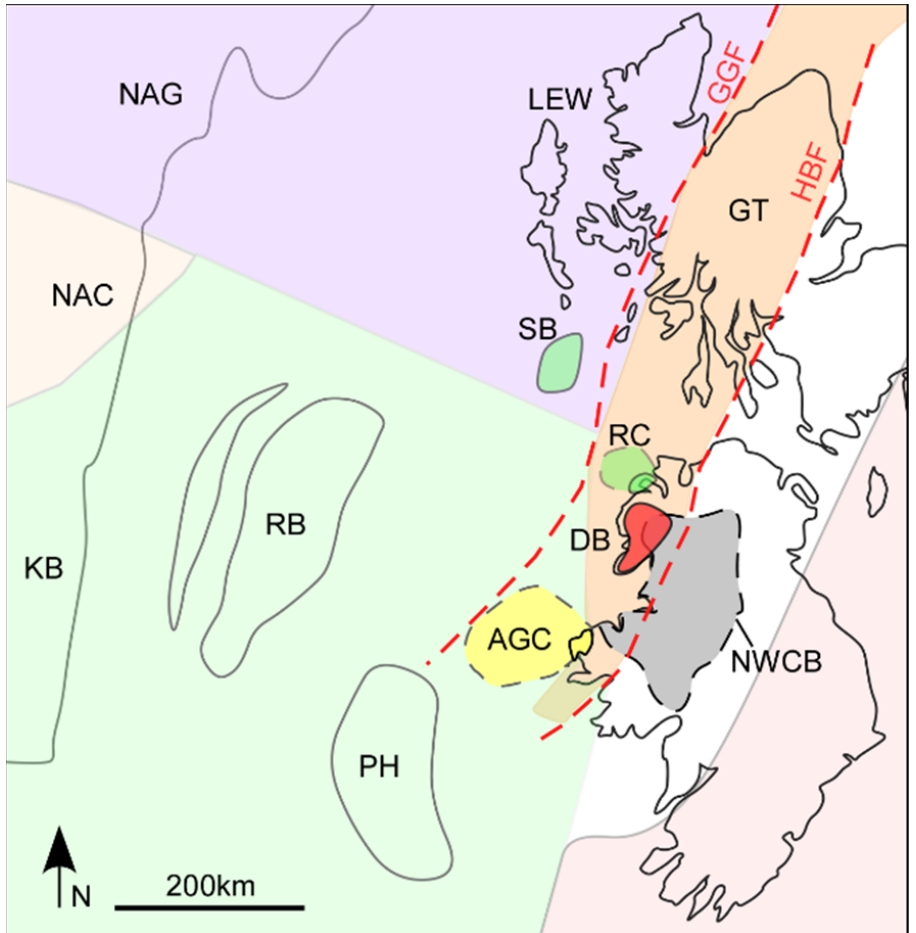
Figure 2. Potential northern source terranes after Anders et al. [48]. NAG: Nagssugtoqidian; NAC: North Atlantic Craton; KB: Ketilidian Belt; LEW: Lewisian; SB: Stanton Banks; RC: Rhinns Complex; RB: Rockall Bank; PH: Porcupine High; ACG: Annagh Gneiss Complex; DB: Donegal Batholith; GT: Grampian Terrane; GGF: Great Glen Fault; HBF: Highland Boundary Fault; NWCB: Northwest Carboniferous Basin.